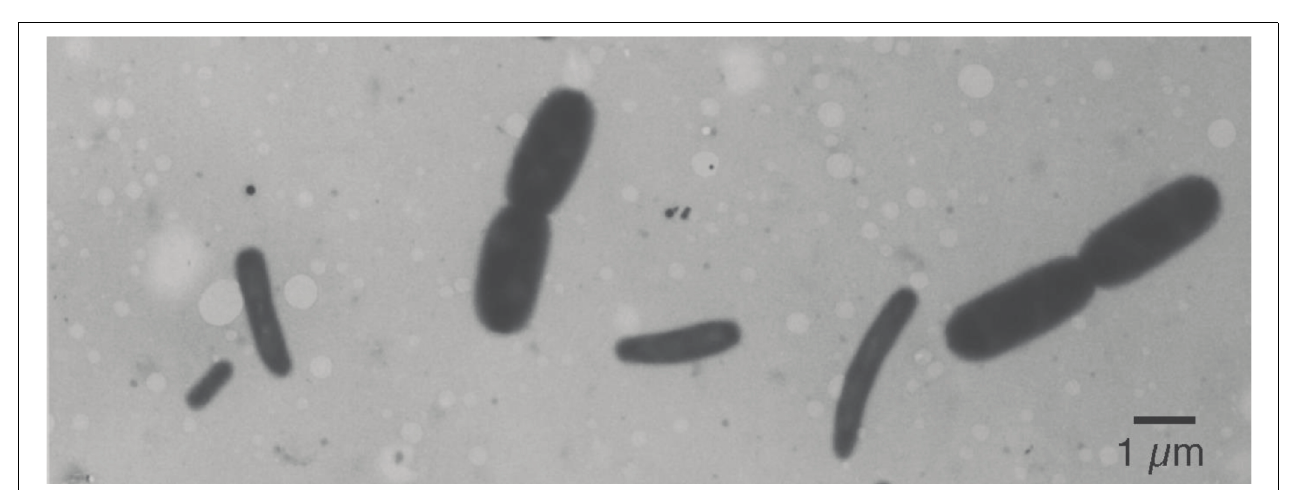
FIGURE 3 | Electron micrograph of a mixture of two E. coli B/r cultures prepared by agar filtration. The big cells were grown in trypton broth with a doubling time of 22 min; the small cells were grown in